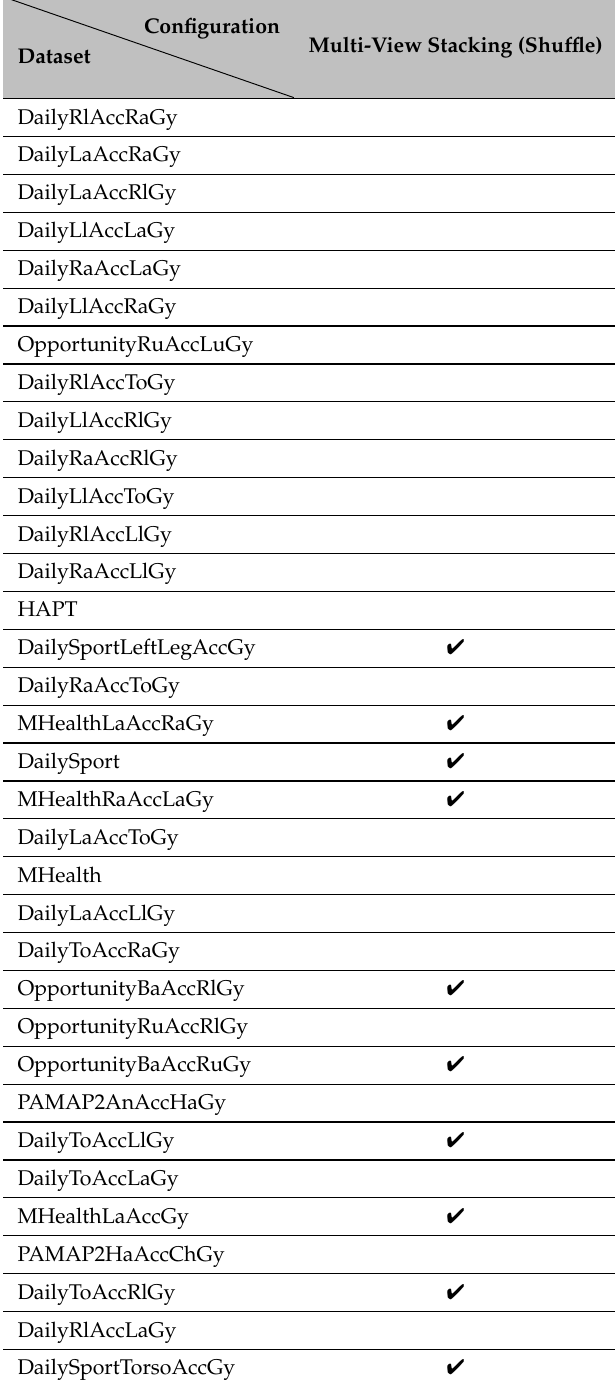
Table 3. Relationship between the Multi-view stacking configuration that shuffles features and the datasets, with respect to the significant differences found when this configuration is compared to the Multi-view stacking configuration that does not shuffle